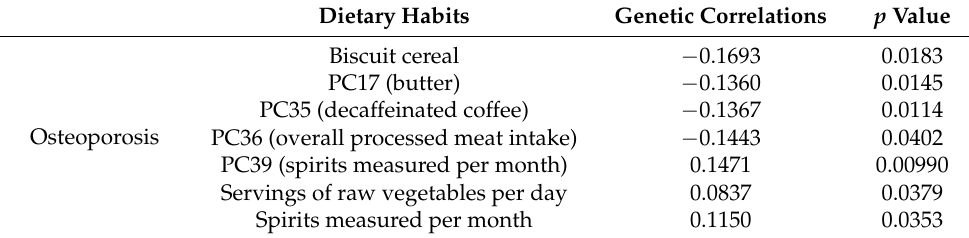
Table 1. The genetic correlations between dietary habits and OP. Dietary Habits Genetic